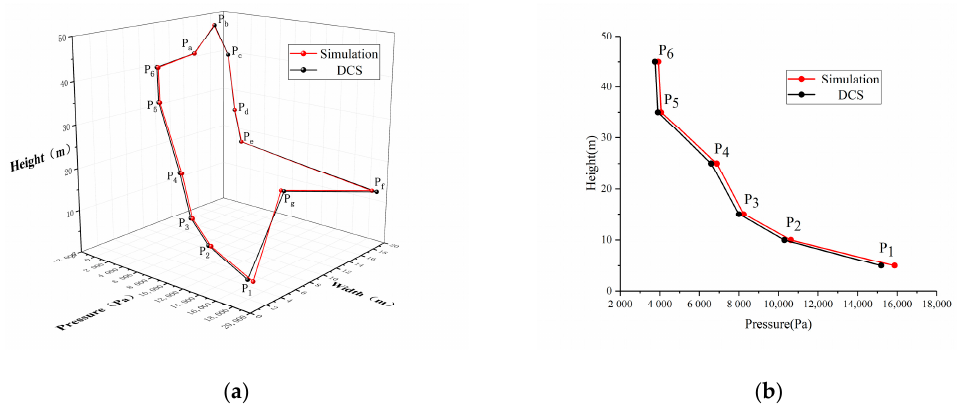
Figure 16. Comparison of simulated and measured pressure of the circuit ( a ) and along the furnace ( b ).